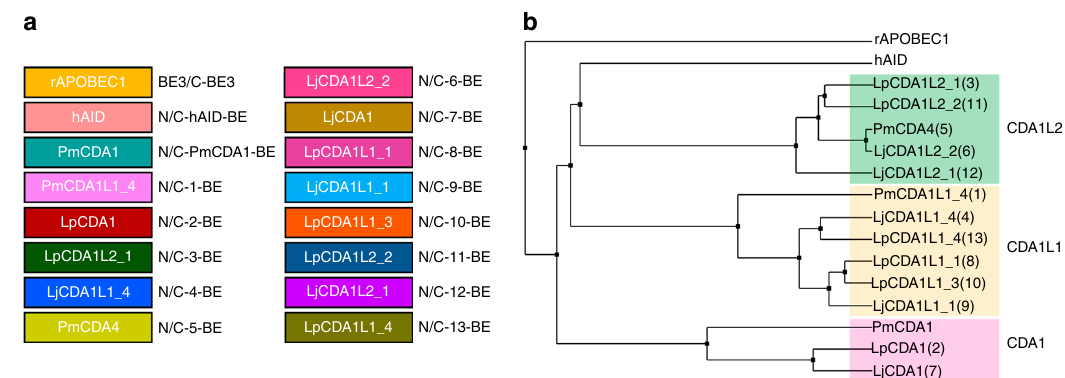
Fig. 1 Potential cytidine deaminases for functional CBEs. a Cytidine deaminases used in this study for the construction of functional CBEs. Deaminases used for the fi rst time were represented as 1 – 13. b Phylogenetic tree analysis for cytidine deaminases used in this study. It was shown that lamprey cytidine deaminases used here could be classi fi ed into three groups: CDA1, CDA1L1, and